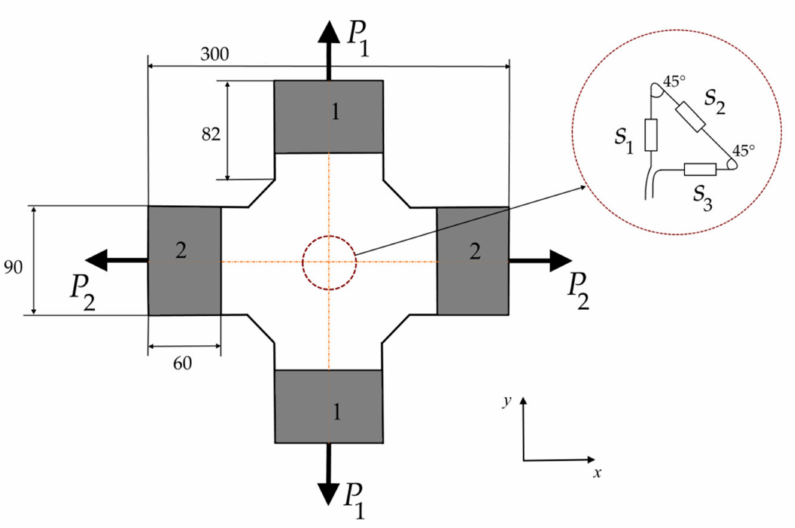
Figure 1. Experimental cross-shaped sample with embedded rosette consisting of sensors s 1 , s 2 , s 3 , located at the single optical